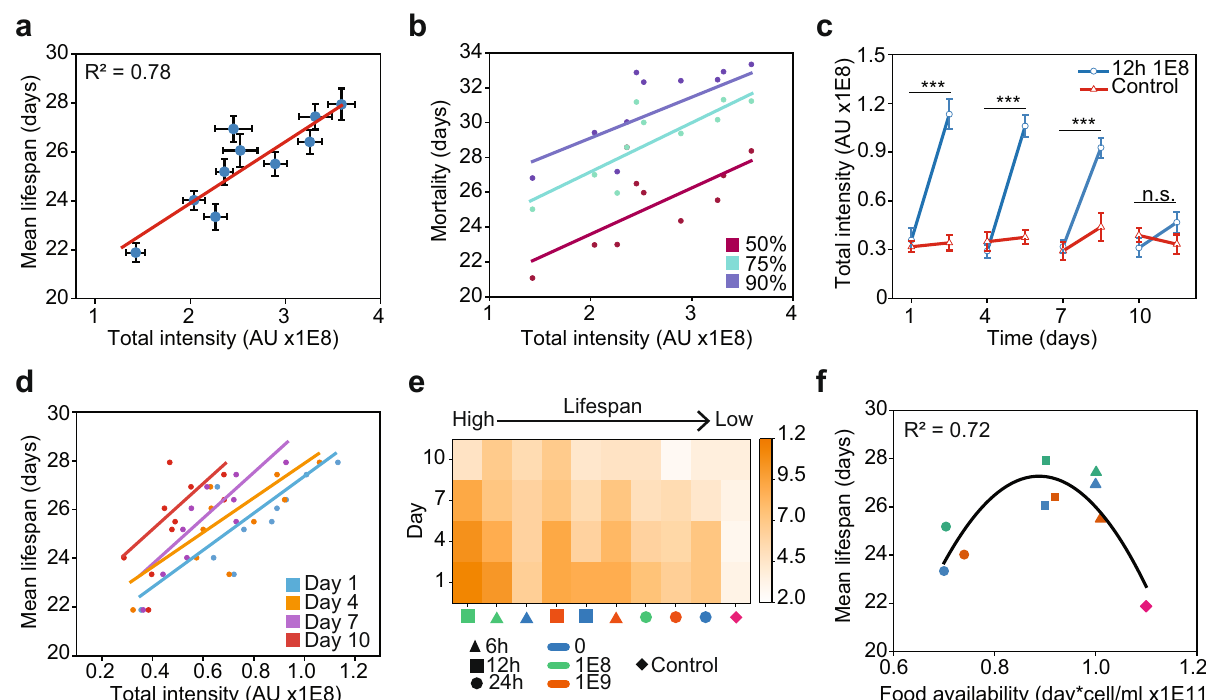
Fig. 3 Cumulative lifelong DAF-16 nuclear activity determines lifespan. a Mean lifespan of C. elegans as a function of lifelong DAF-16 total intensity under various DR regimes. b Mortality of C. elegans populations as a function of DAF-16 lifelong total intensity. c DAF-16 total intensity at a 10 8 OP50 cells/ml food concentration with 12 h of exposure time compared to an ad libitum control at Day 1, 4, 7, and 10 of adulthood. d Mean lifespan as a function of DAF-16 total intensity in individual days. e Heat map of DAF-16 total nuclear intensity per day under different DR regimes, in order of higher to lower lifespan (left to right). f Mean lifespan as a function of total food available during the fi rst 11 days of animal adulthood. 6 h (triangles) and 12 h (squares) regimes are at the peak of the curve while 24 h (circles) regimes and the control (diamond) are at the lower ends of the curve. Error bars are SEM. p > 0.05 (n.s.), p < 0.001 (***). All p -values were calculated using Tukey HSD for all pairwise comparisons after one-way ANOVA (unequal variances) comparison. Linear and quadratic polynomial fi ts were performed in Origin